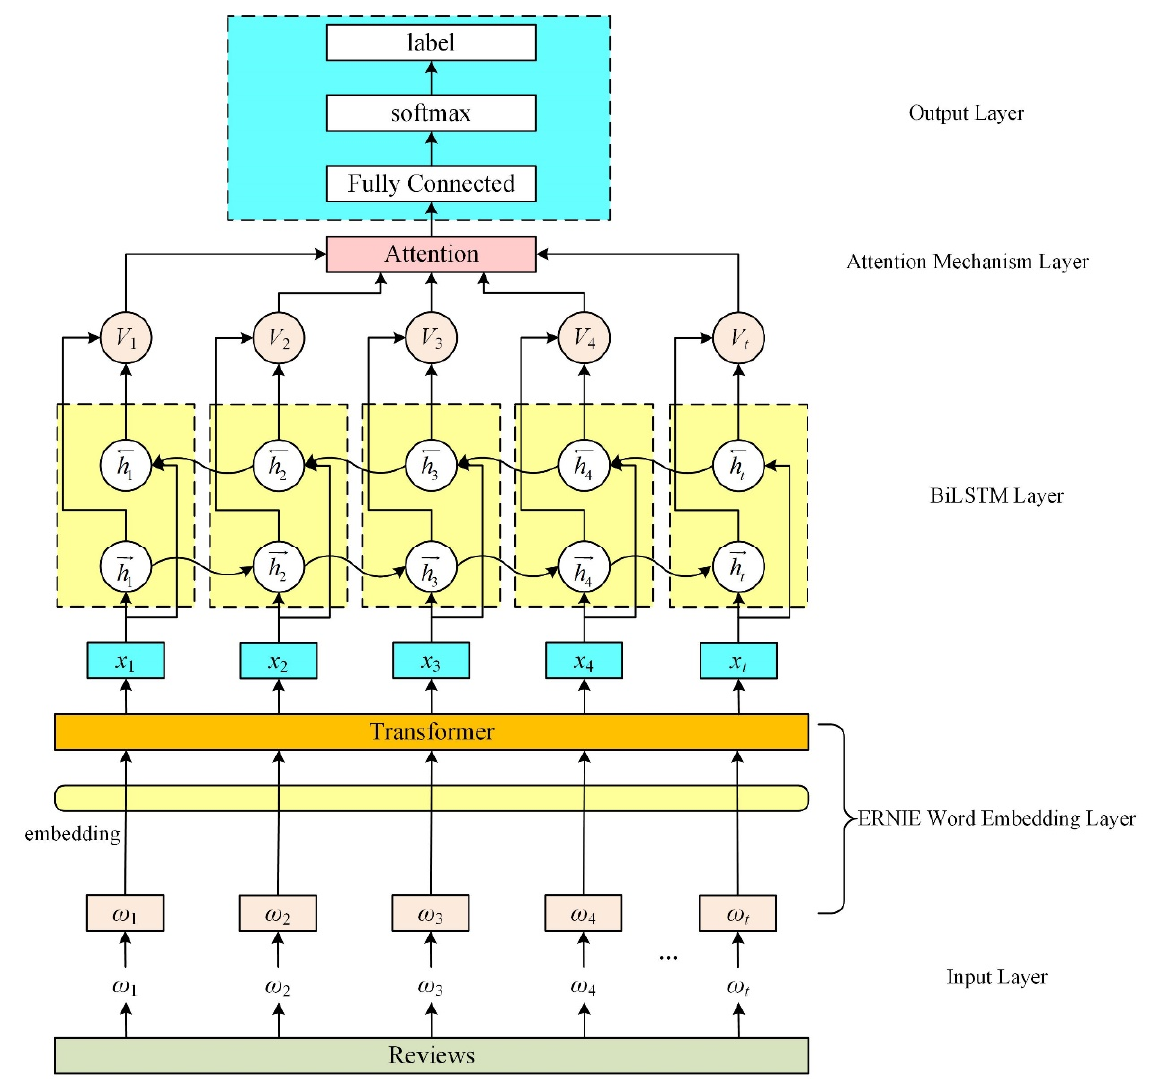
Figure 5. The structure of the EBLA